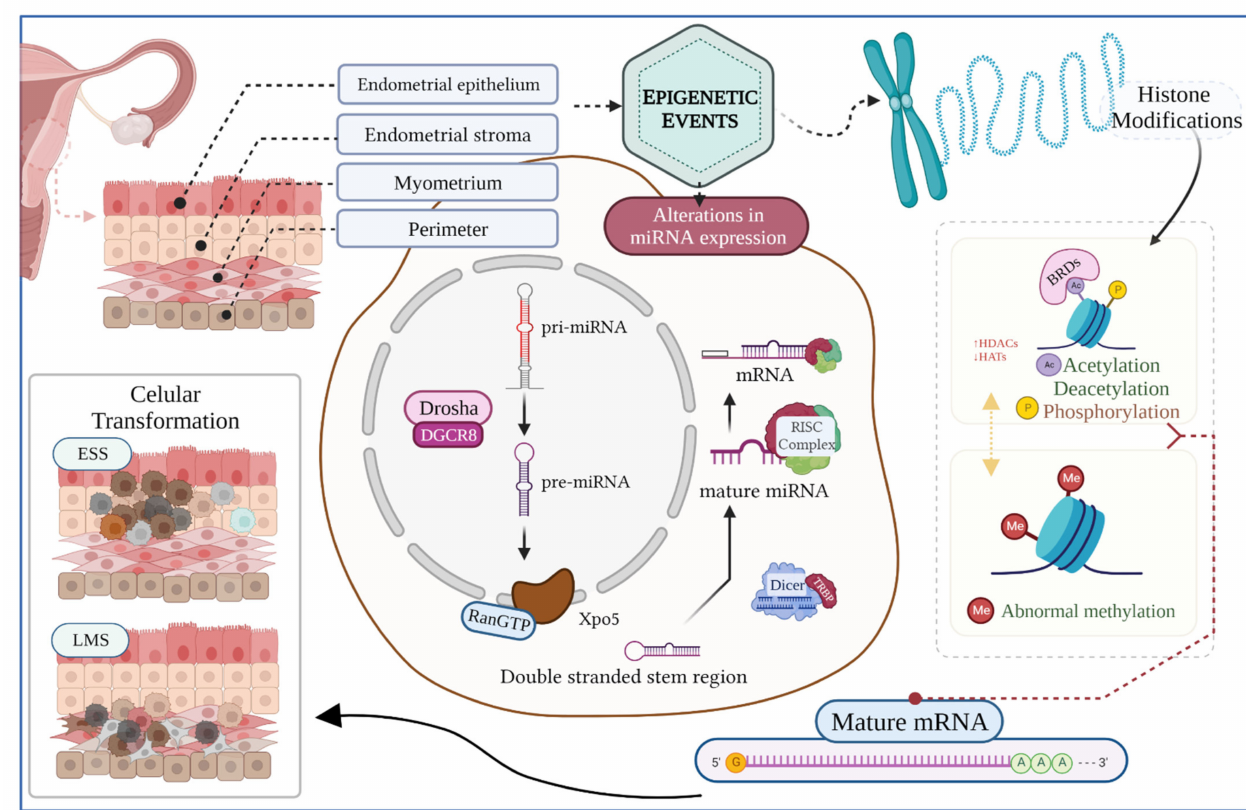
Figure 2. Graphical representation of epigenetic events potentially involved in the initiation and development of the tumors, including uterine LMS and ESS. The biogenesis of miRNAs starts in the nucleus and ends in the cytoplasm. This process includes the participation of several enzymes and protein complexes that regulate the production of mature molecules capable of regulating gene expression, both through induction of mRNA degradation and translational repression. Likewise, dynamic alterations of histone modifications, including acetylation, methylation, and phosphoryla- tion, modify gene expression, thus affecting DNA replication and repair, chromatin compaction, and cell cycle control. In addition, histone modification readers such as BRDs can recognize modified histones, therefore altering gene expression and responding to different signals. Dysregulation in the epigenetic machinery leads to malignant transformation of cells culminating in the development of cancer. Created with